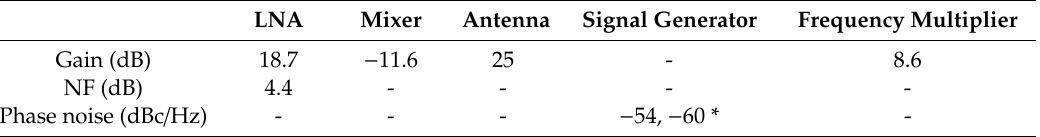
Table 1. Performance of W-band radar components. LNA